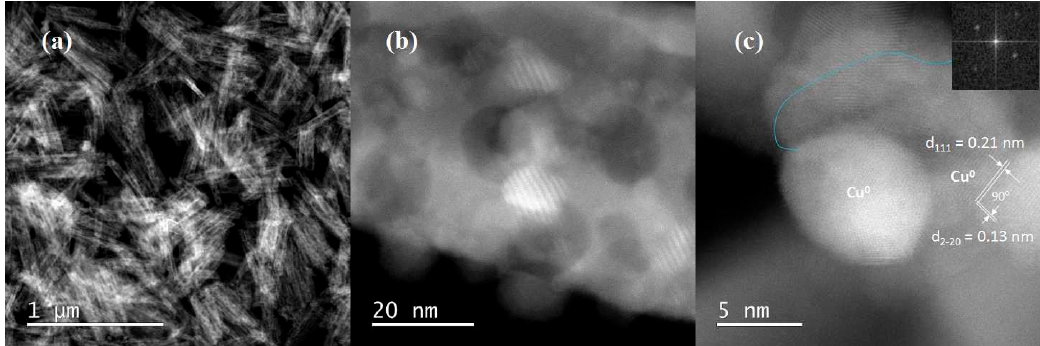
Figure 6. HAADF-STEM image of the Cu/Fe 3 O 4 rods. ( a , b ) are images with different magnification; ( c ) is high resolution STEM image with inset of EDX.